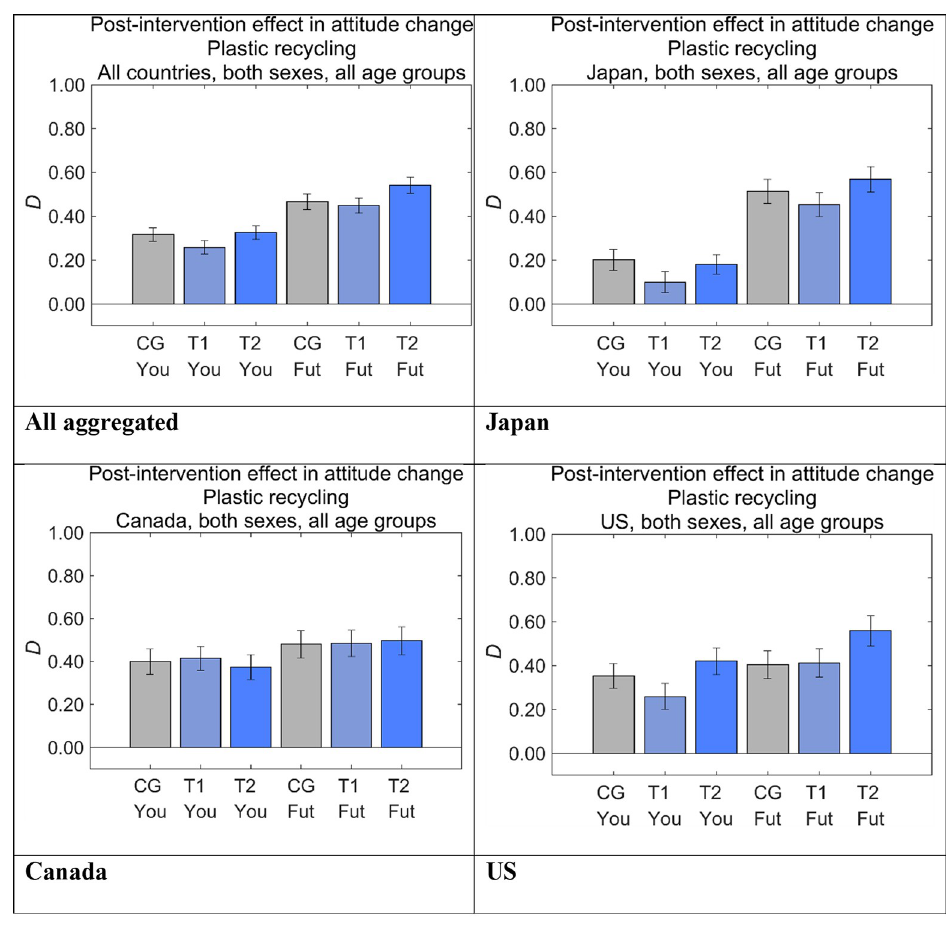
Fig 11. Post-intervention effect in attitude change toward disposable plastics ( D ). Higher values on the vertical axis indicate lower perceived danger of disposable plastics. Error bars show 95% confidence intervals. CG, control group; T1, treatment group 1; T2, treatment group 2; Fut, Future Generations; You,